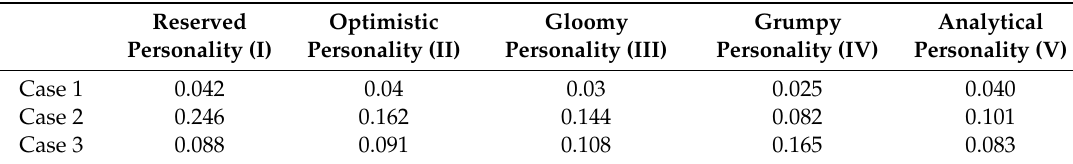
Table 12. Minkowski distance.